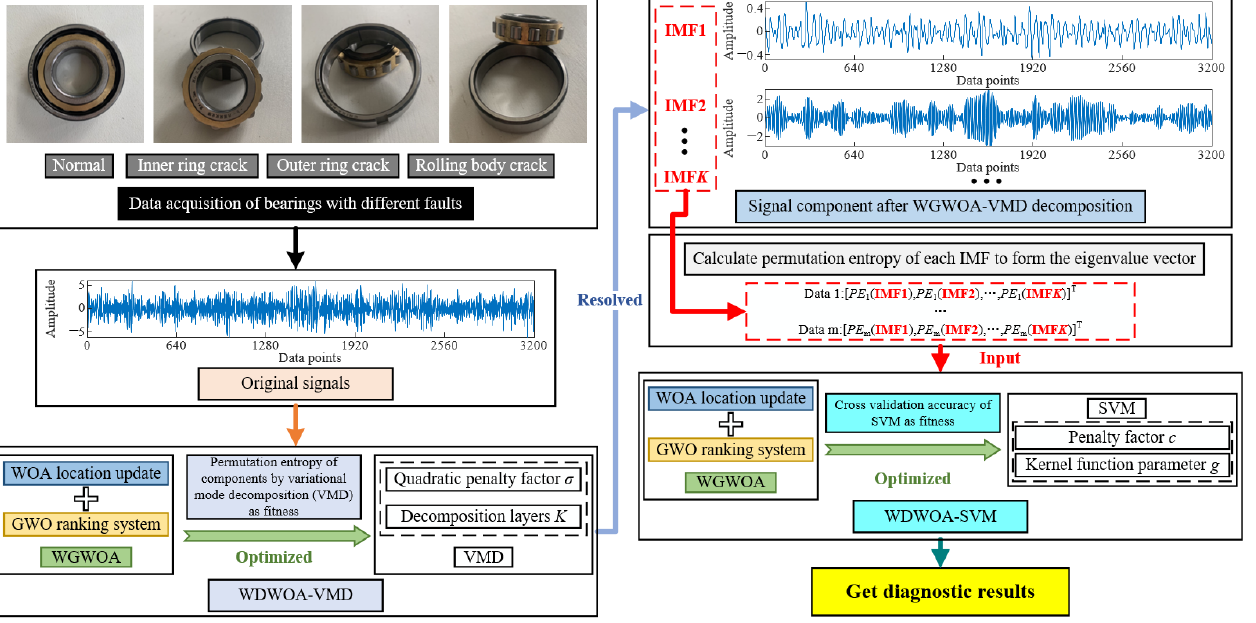
Figure 3. Fault diagnosis of rolling bearing based on WGWOA-VMD-SVM.